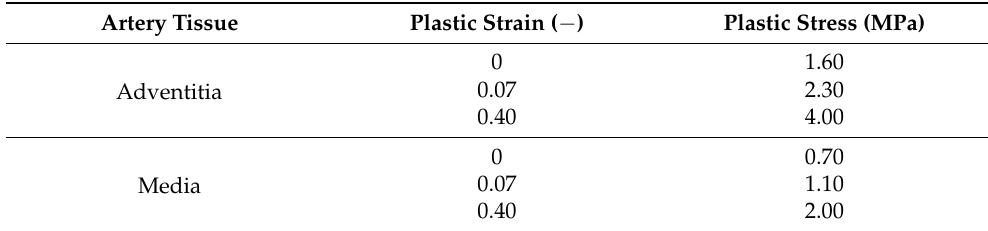
Table 2. Plastic parameters for the adventitia and the media. The stress value corresponding to null plastic strain indicates the yielding